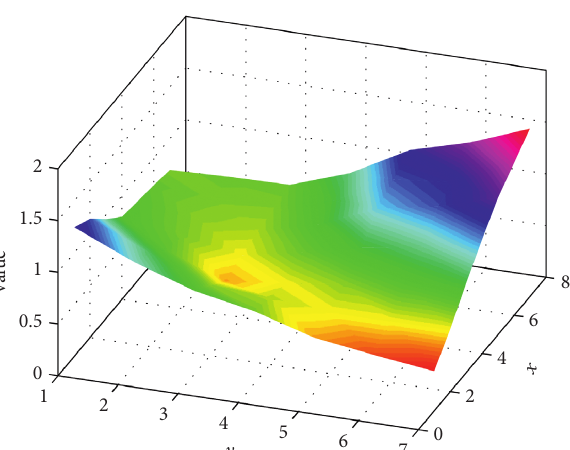
Figure 9: Predicted